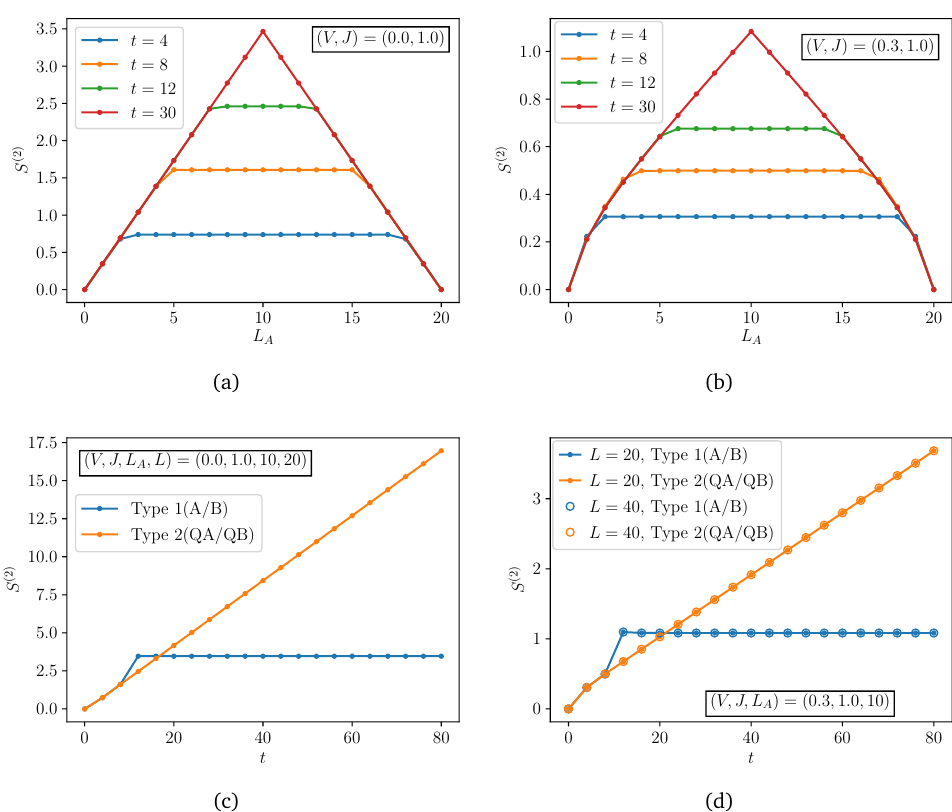
Figure 3: (a) Subsystem scaling of S ( 2 ) at various t with V = 0. (b) Subsystem scaling of S ( 2 ) at various t with V = 0.3. (c) Time dependence of the two saddle solutions at V = 0, obtained by using numerical initial conditions Type 1(A / B) and Type 2 (QA / QB), respectively. (d) Time dependence of the two saddle point solutions at V = 0.3. The result from two system sizes L = 20 and L = 40 shows there is no observable finite size